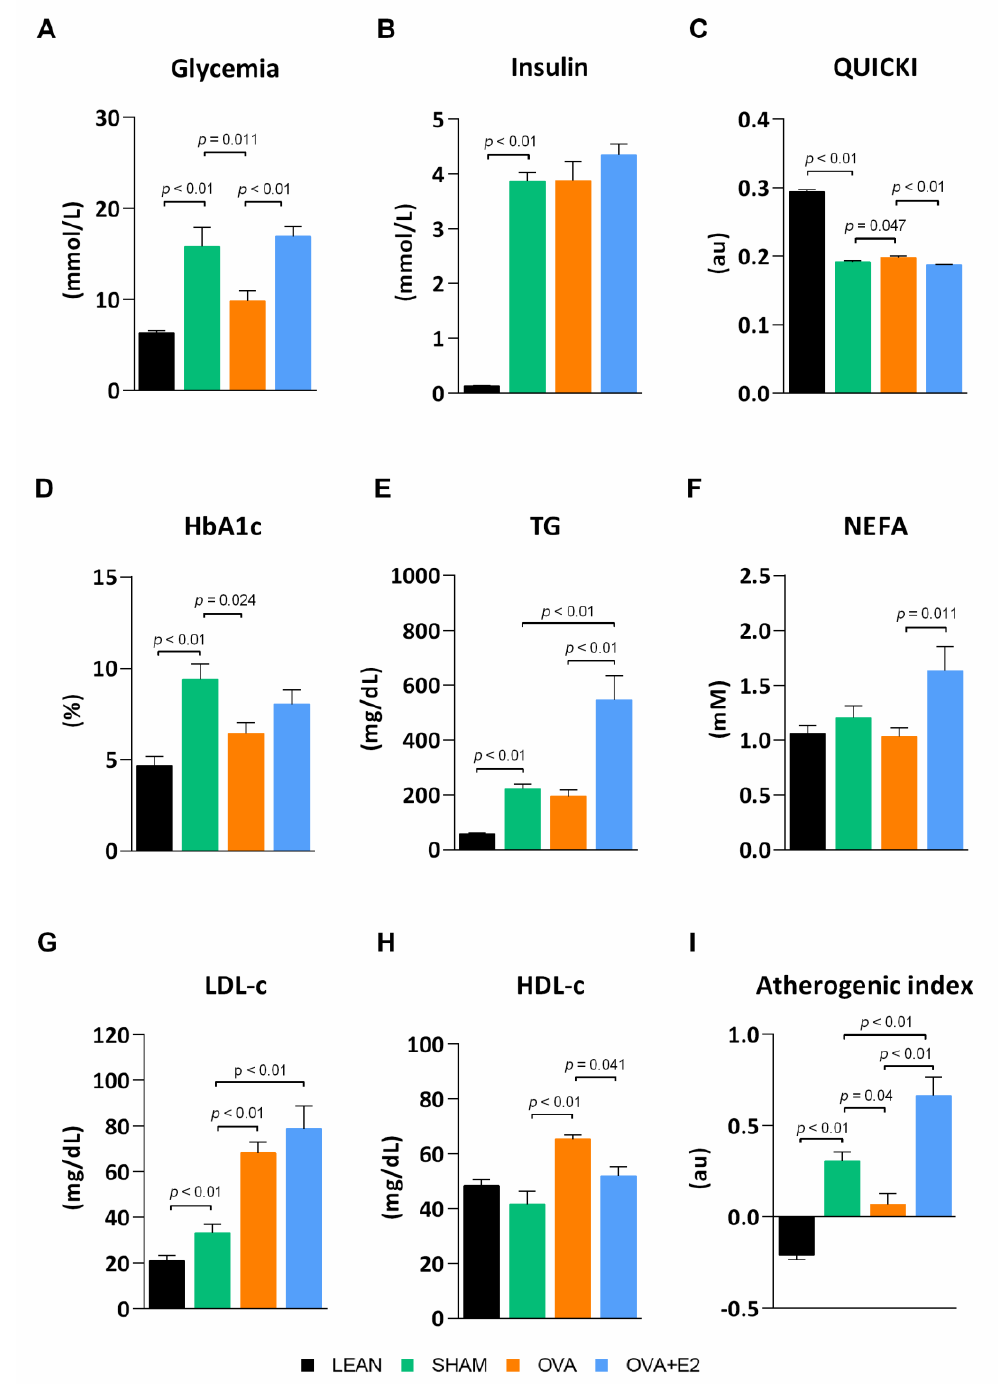
Figure 2. Ovariectomy and E2 treatment effects on serum metabolic parameters. ( A ) Glycemia. ( B ) Insulin levels. ( C ) QUICKI. ( D ) HbA1c. ( E ) TG. ( F ) NEFA. ( G ) LDL-c. (H) HDL-c. ( I ) Atherogenic index of plasma. QUICKI, Quantitative insulin sensitivity check; HbA1c, glycated hemoglobin; TG, triglycerides; NEFA, non-esterified fatty acids; LDL-c, low- density lipoprotein cholesterol; HDL-c, high-density lipoprotein cholesterol. LEAN, control rats (fa/+); SHAM, obese- diabetic (fa/fa) rats undergoing sham surgery; OVA, ovariectomized obese-diabetic (fa/fa) rats; OVA + E2, OVA rats treated with E2 (3 µg/day) for 5 weeks. Values are expressed as the mean ± SEM. Differences between obese-diabetic (SHAM) and control (LEAN) animals were analyzed by Student’s t -test. Differences between obese-diabetic groups with different hormonal manipulation were analyzed by One- way ANOVA with Fisher’s LSD post -hoc test.